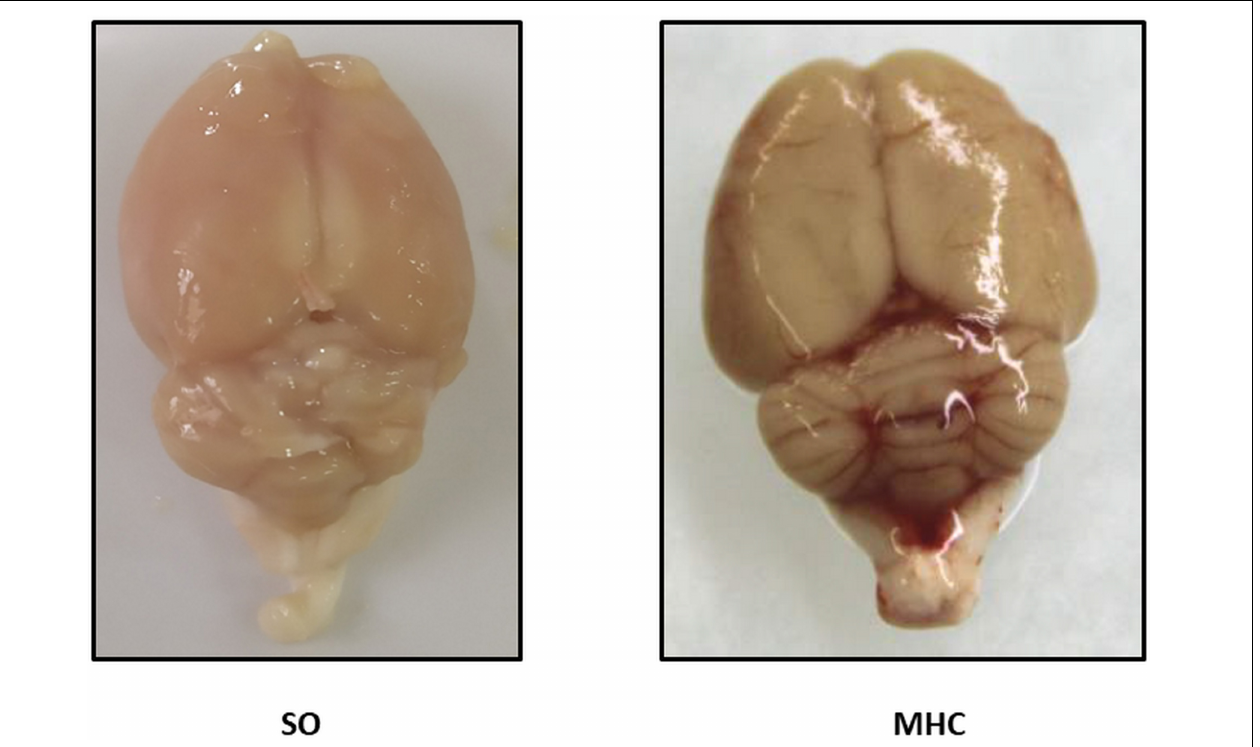
FIGURE 1 | Representative pictures showing the brains from Sham-Operated (SO) and rats submitted to microsurgical liver cholestasis (MHC).